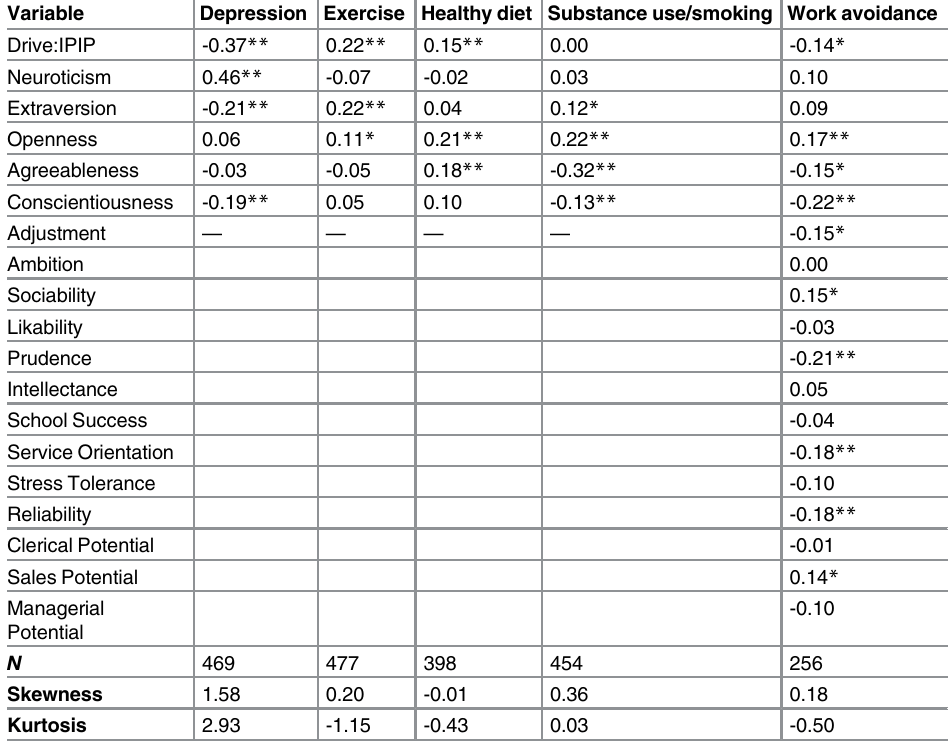
Table 10. Descriptive Statistics and Bivariate Correlations of Criteria with Drive:IPIP, NEO PI-R Domains, and HPI Primary and Occupational Scales in the Eugene-Springfield Community Sample.